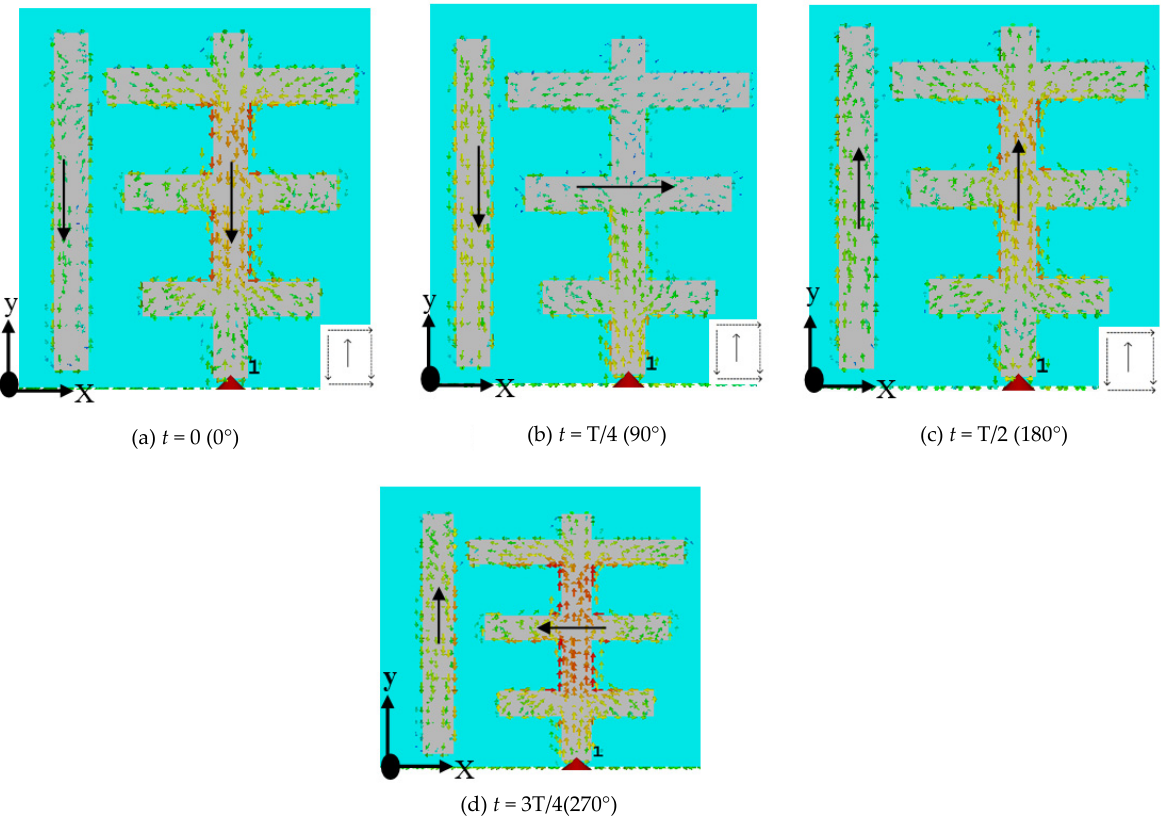
Figure 5. Distribution of simulated current at 3.75 GHz at: ( a ) t = 0 (0 ◦ ), ( b ) t = T/4 (90 ◦ ), ( c ) t = T/2(180 ◦ ), and ( d ) t = 3T/4(270 ◦ ). given that the x-component contributes to E θ while the y-component contributes to E . To further study the broadband CP property of